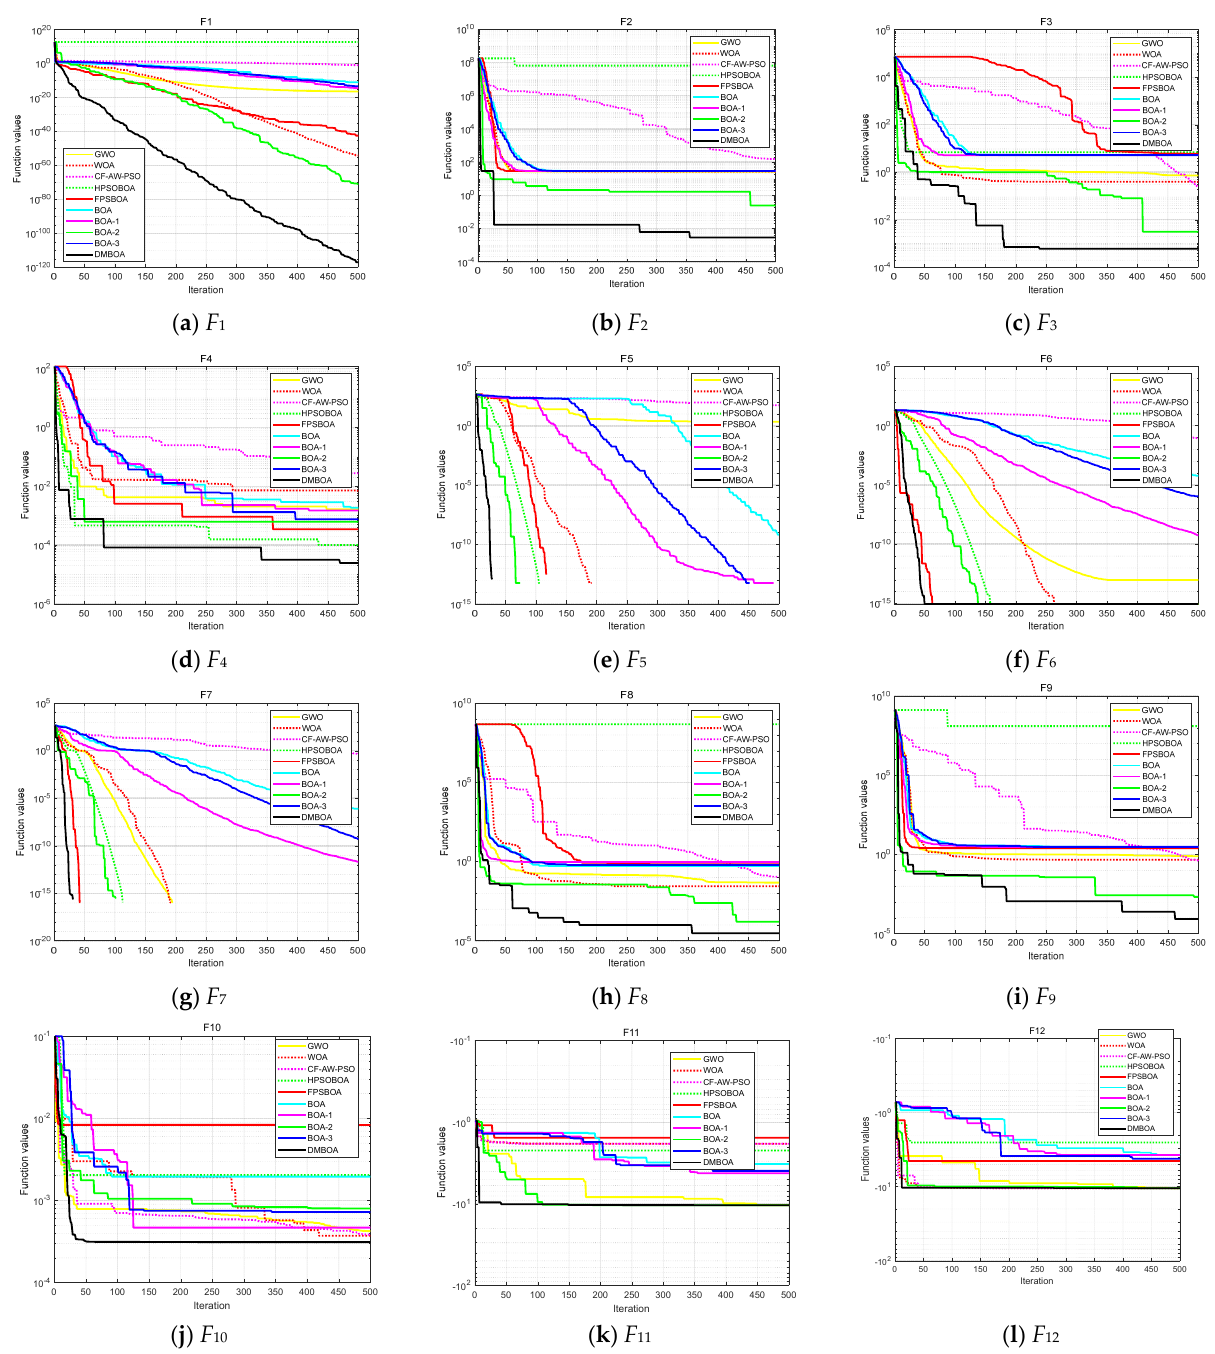
Figure 4. Convergence curves of 10 algorithms on 12 test function in Table 2. Table 4. Data of speech signal separation performance evaluation